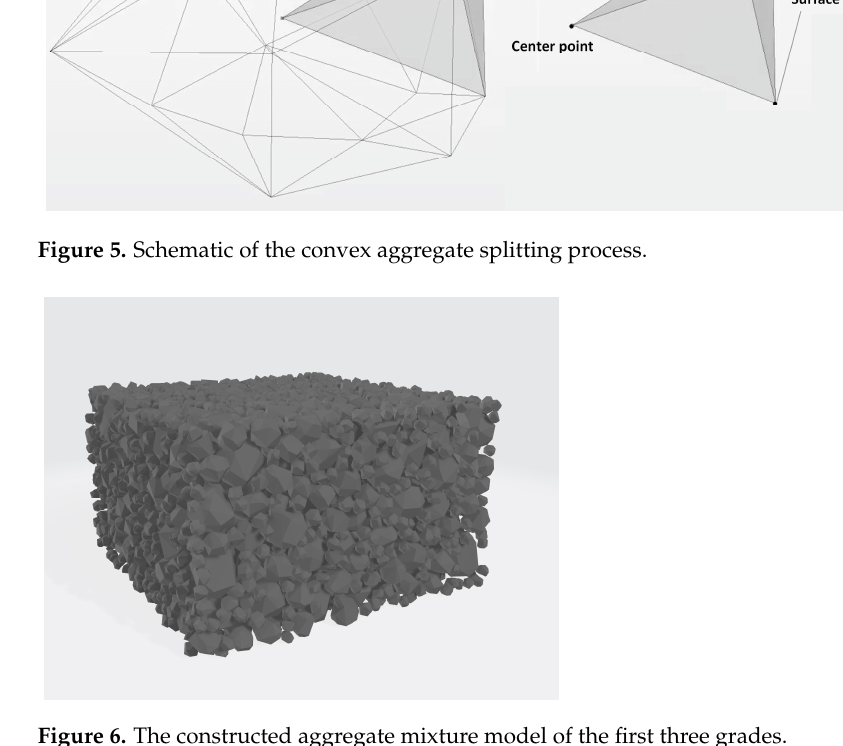
Figure 6. The constructed aggregate mixture model of the fi rst three